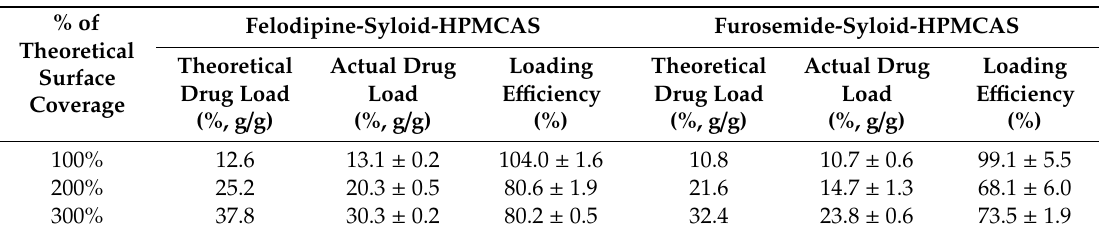
Table 2. Drug load and loading e ffi ciency of Felodipine and Furosimide in mesoporous silica Syloid XDP 3050 with the incorporation of